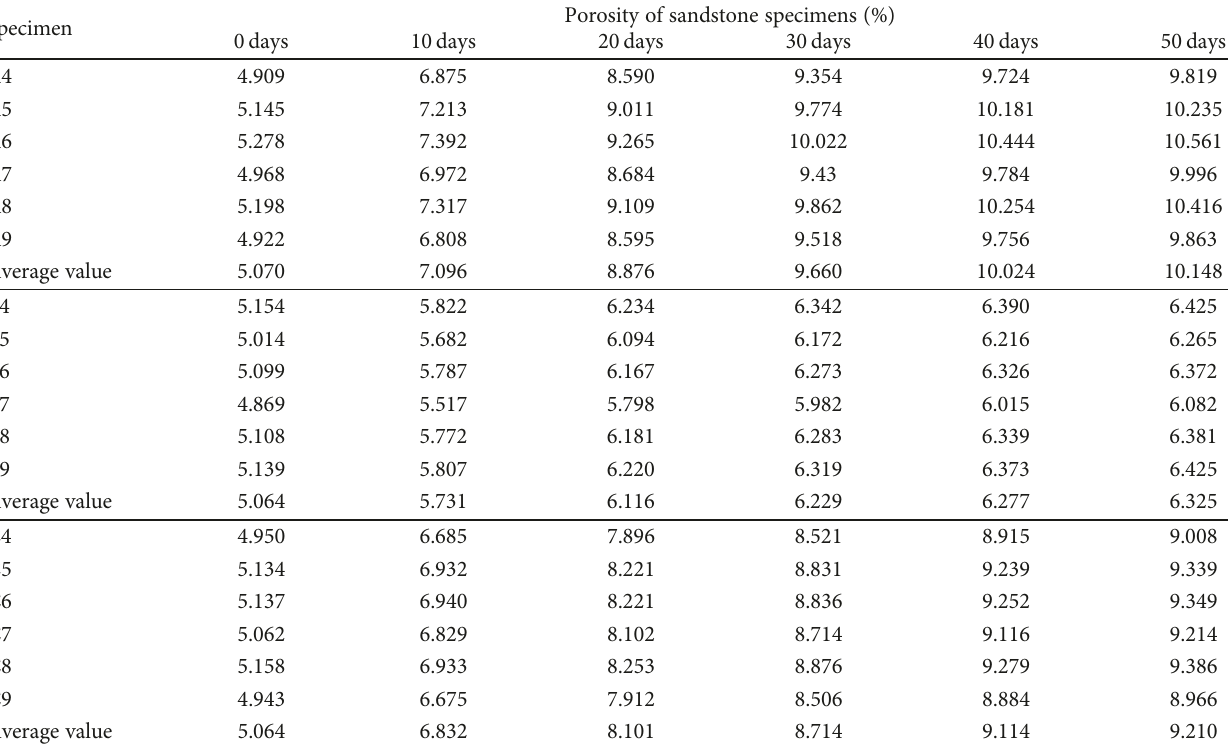
Table 2: Porosity of specimens with di ff erent times of immersion in chemical